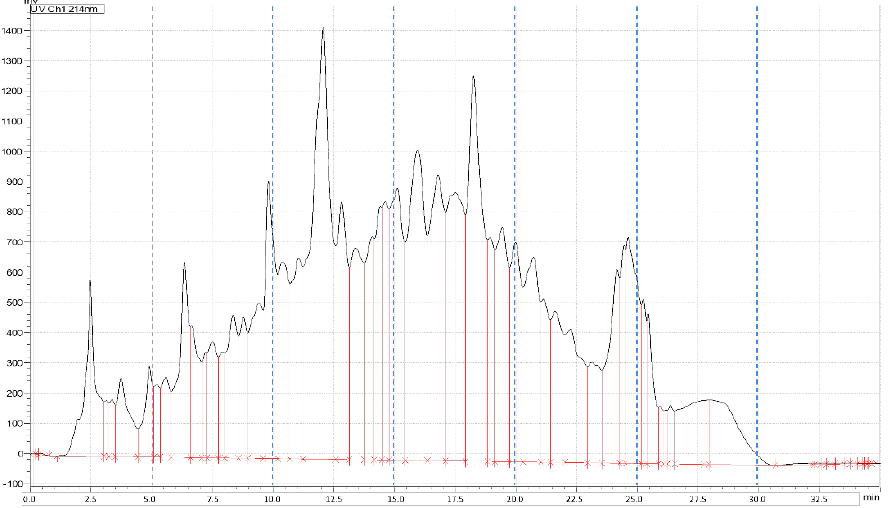
Figure 1. LC-UV chromatogram of hydrolyzed soybean extracts showing the applied fractiona- tion.